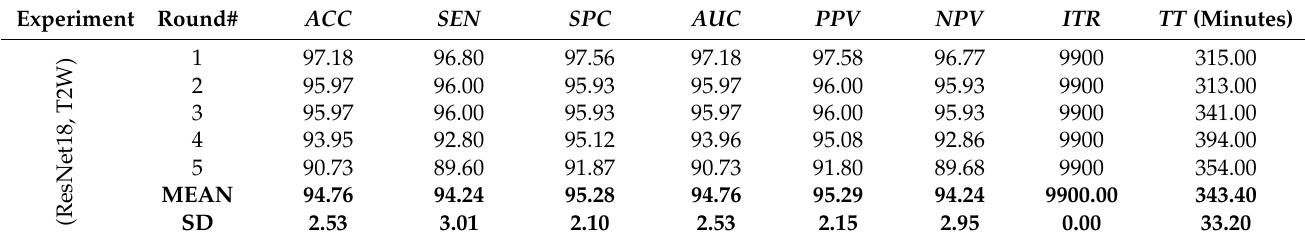
Table A10. Test results of five-folds of the experiment (VGG16, T2W).